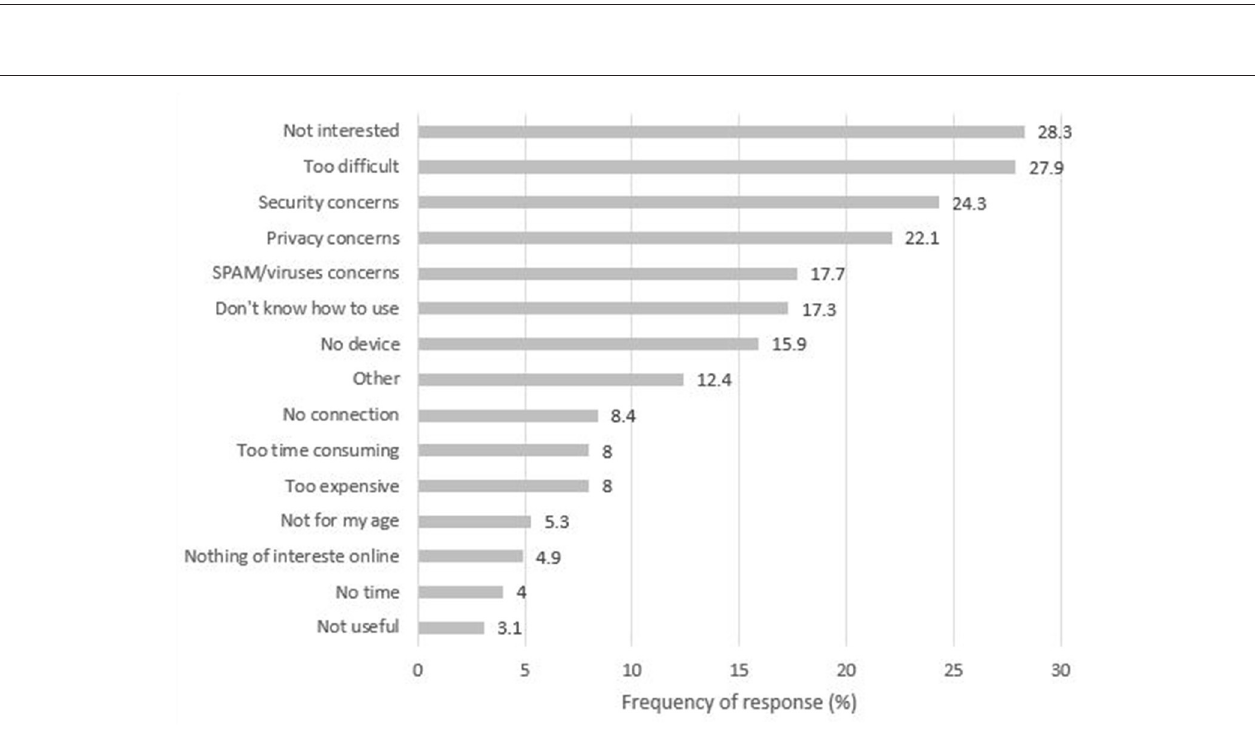
FIGURE 3 | Barriers for using the Internet among limited or non-users of the Intemet ( N = 226).